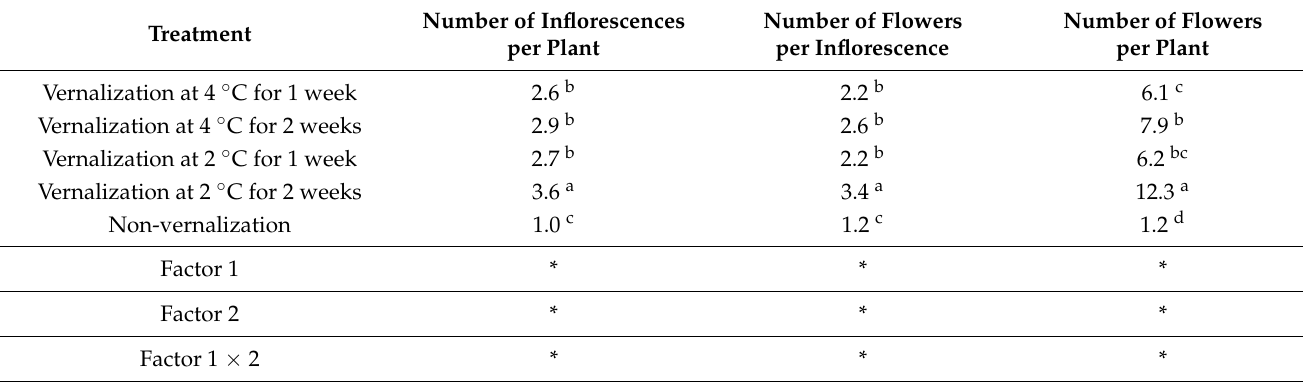
Table 3. Effects of vernalization on number of inflorescences, number of flowers per inflorescence and number of flowers per plant in strawberry cv. Pharachatan 80.